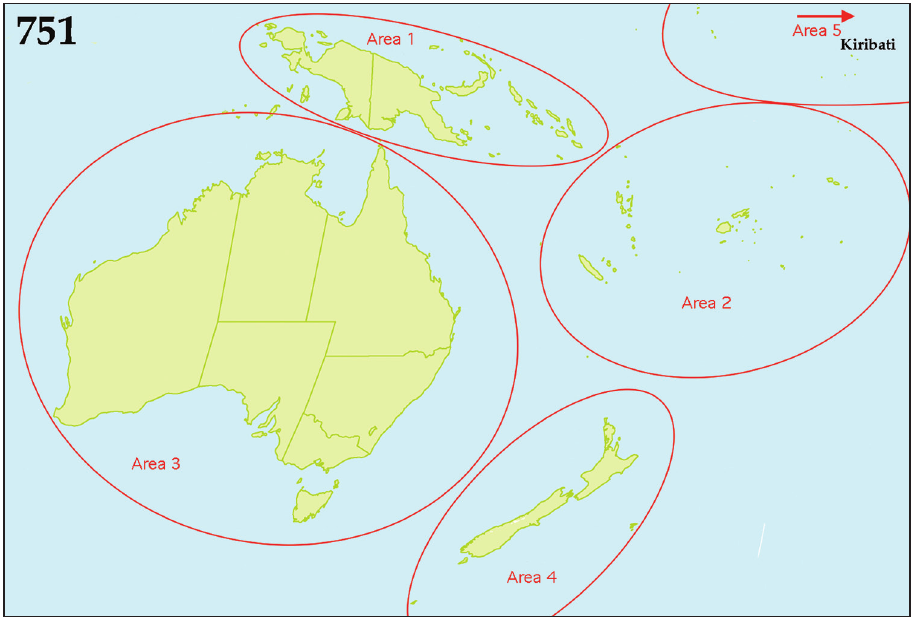
Figure 751. Australopacific Region with depicted